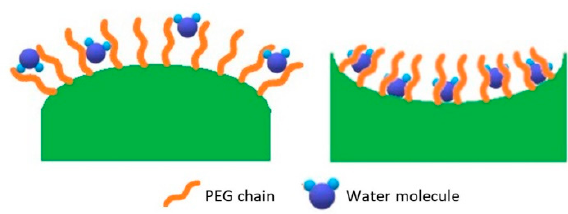
Figure 7. Water distribution on nanoparticles with varying curvatures.